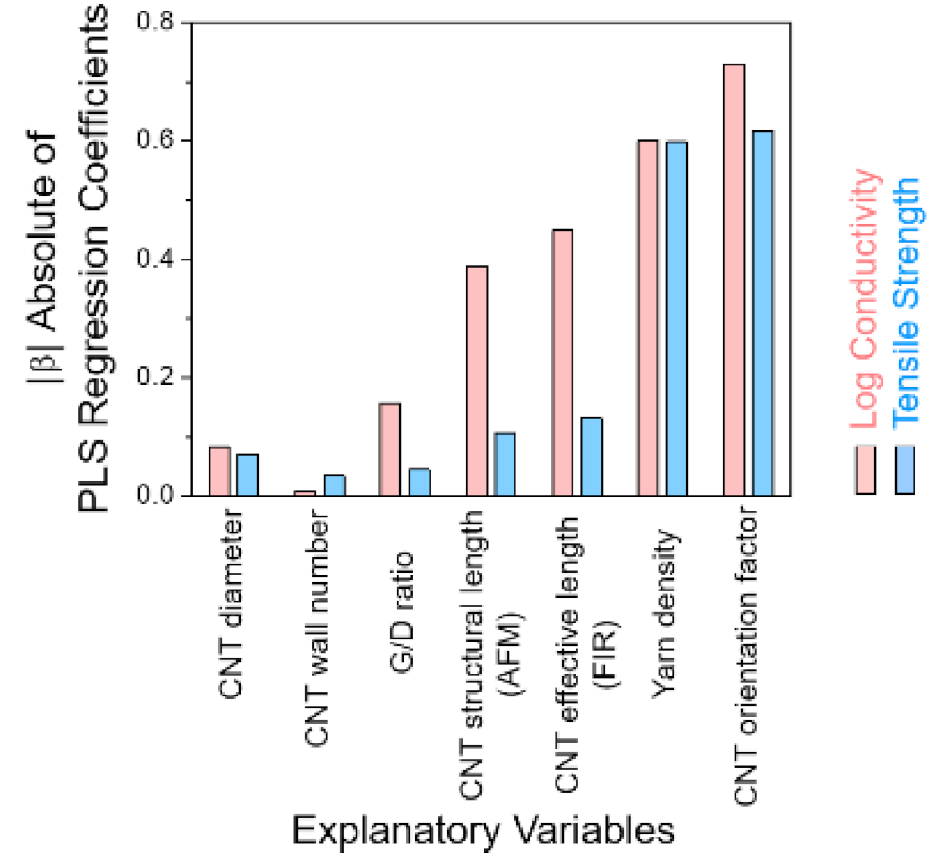
Figure 8. PLS analysis of the electrical conductivity and tensile strength of CNT